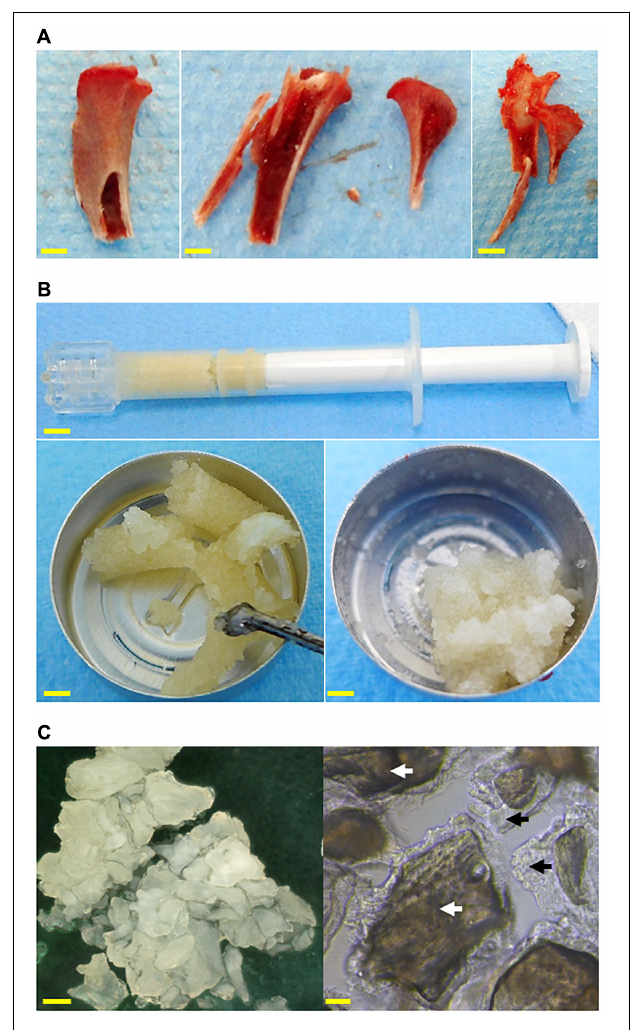
FIGURE 1 | Images of the grafts used to fill the calvarial critical bone defects. (A) Syngeneic bone graft harvested in a proximal tibia, from left to right: before being cut, after being cut, and after bone harvesting. (B) The bone paste in a syringe (top, scale bar: 5 mm) after extrusion (left, scale bar: 3 mm), and after modeling (right, scale bar: 3 mm). (C) Microscopic observations of the bone paste particles in air (left, reflected light, scale bar: 300 µ m) or in water (right, transmitted light, scale bar: 50 µ m). Mineralized core: white arrows, demineralized bone matrix: black